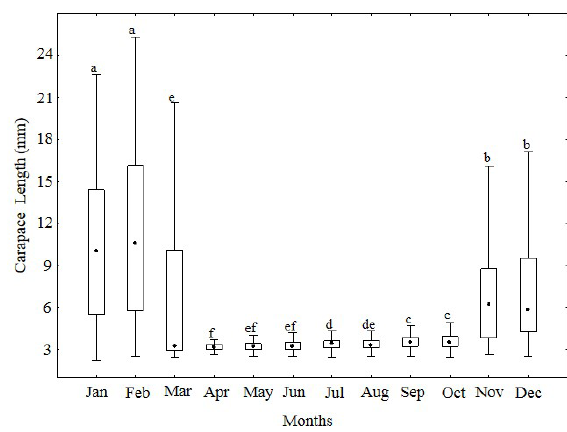
Figure 7. Monthly median size variation of Macrobrachium olfersii in Ribeira de Iguape river, São Paulo, Brazil, from January to December 2007. The boxplot shows the median: 75% and 25% quartiles; the whiskers indicate the non-outlier range; Kruskal- Wallis test: different letters indicate significant differences between months at